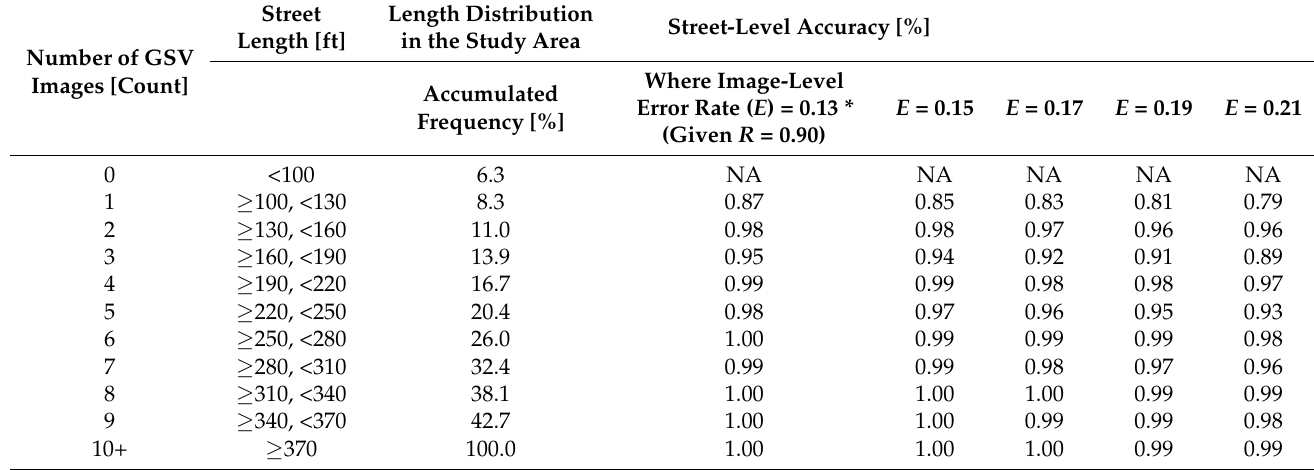
Table 3. Street-level accuracy rate given different levels of image-level accuracy 0.79 ( E = 0.21) and 0.87 ( E =